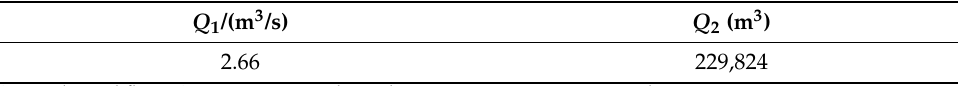
Table 4. The minimum ecological water demand of Liuan